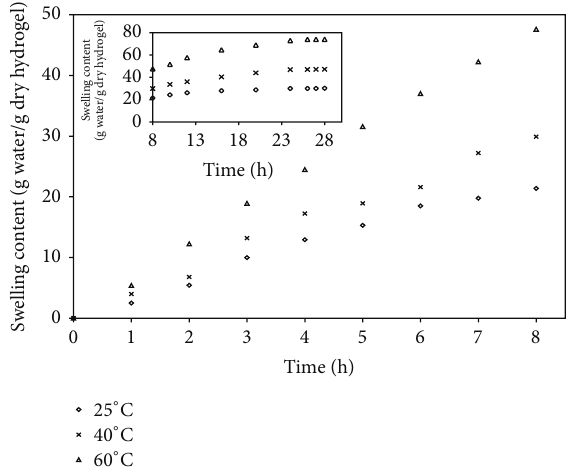
Figure 2: Swelling of hydrogel as a function of time at different